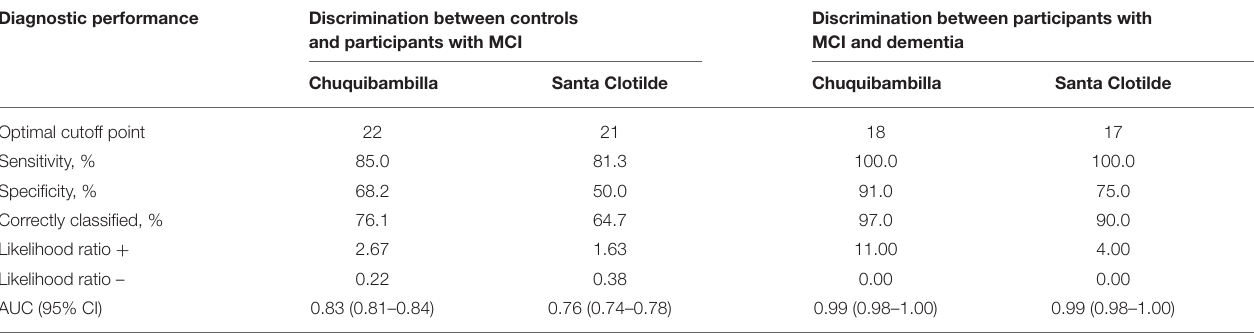
TABLE 3 | Cut-off points and diagnostic performance for the Peruvian version of the Rowland Universal Dementia Assessment Scale (RUDAS-PE) to discriminate between controls and participants with mild cognitive impairment (MCI) and dementia in Chuquibambilla, Junín and Santa Clotilde, Loreto. Diagnostic